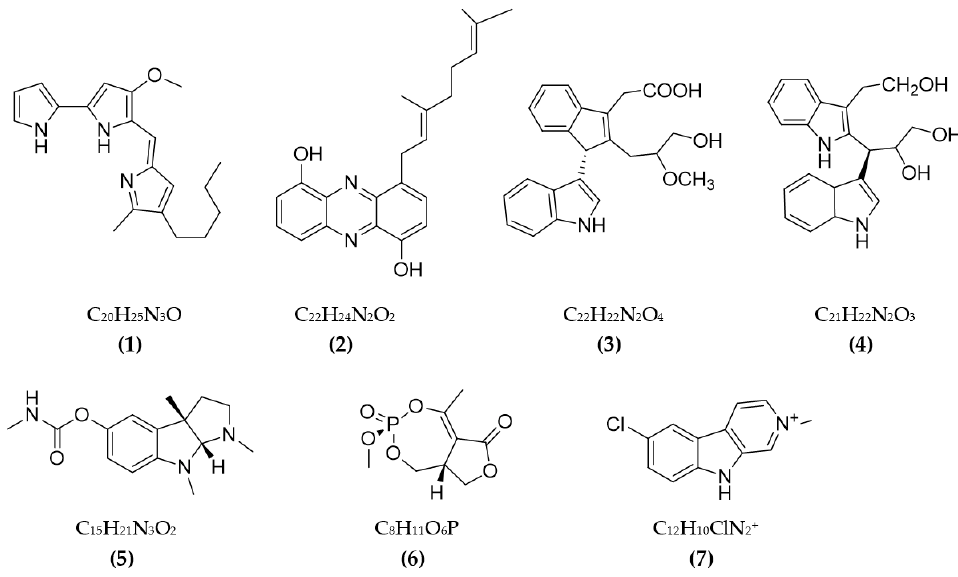
Figure 2. The chemical structures and chemical formula of ChE inhibitors from bacteria.